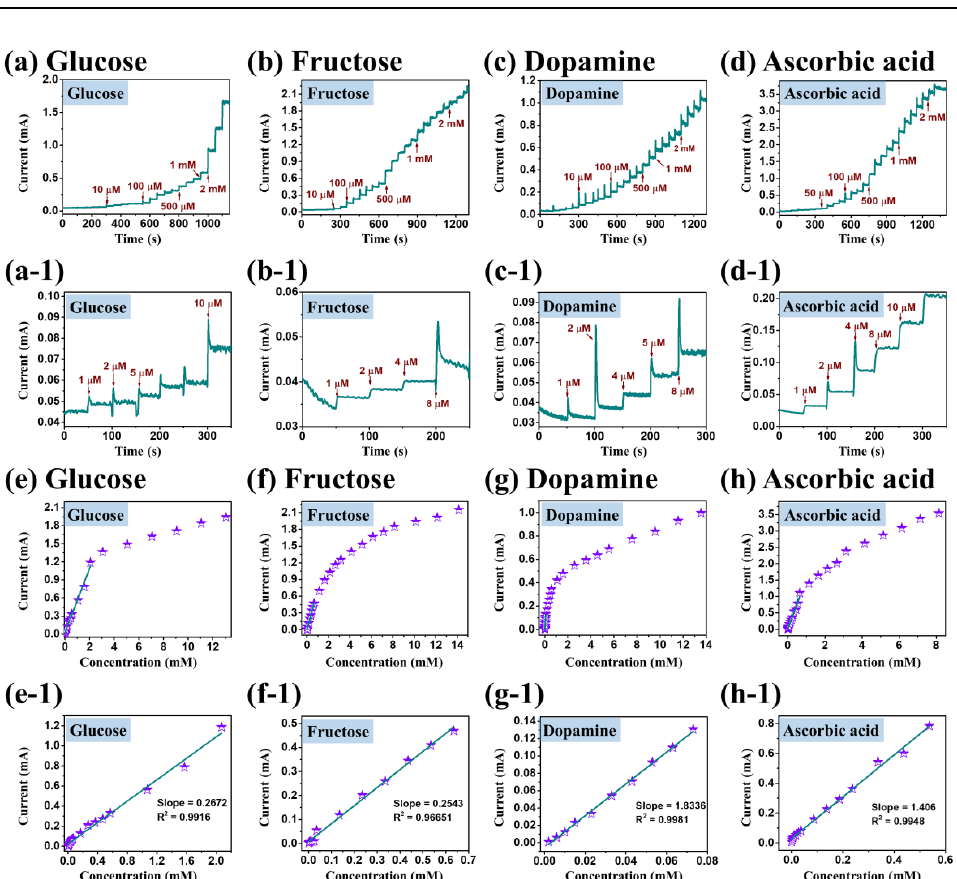
Figure 8. Amperometric response of CuO-5A sample upon dropwise addition of ( a ) glucose into 0.1 M NaOH at a potential of 0.6 V, ( b ) fructose into 0.1 M NaOH at a potential of 0.4 V, ( c ) dopamine into 0.1 M PBS at a potential of 0.6 V and ( d ) ascorbic acid into 0.1 M NaOH at a potential of 0.5 V, respectively. ( a-1 – d-1 ) Amperometric response of glucose, fructose, dopamine and ascorbic acid at lower concentrations. ( e – h ) Calibration curves CuO-5A based on the current versus high concentration of glucose, fructose, dopamine and ascorbic acid. ( e-1 – h-1 ) Linear calibration curve based on the current versus low concentration of glucose, fructose, dopamine and ascorbic acid.